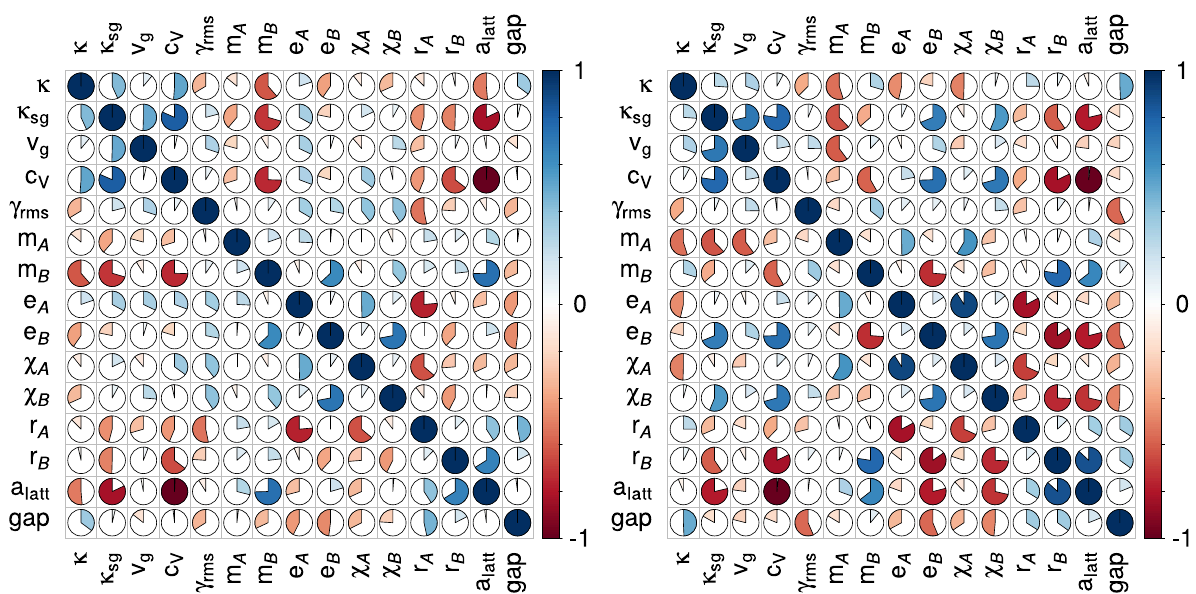
FIG. 7. Correlograms between the thermal conductivity κ , the thermal conductivity in the small grain limit κ velocity v , the heat capacity c , the root-mean-square Grüneisen parameter γ g V perovskite ABX 3 , their electronegativities e , e , their Pettifor scales χ A B compound a , and its electronic band gap, for mechanically stable fluorides (left) and oxides (right) at 1000 latt